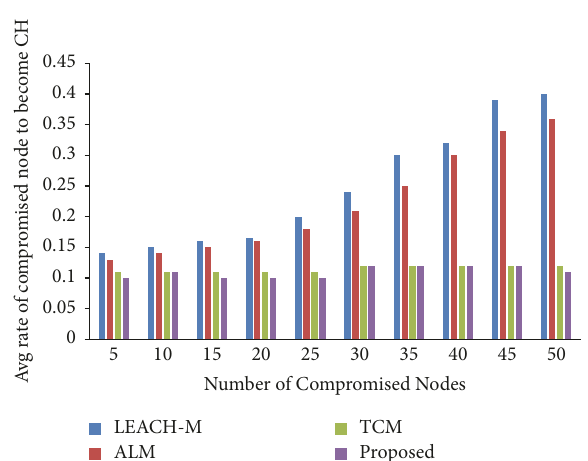
Figure 2: Average rate of compromised node become CH versus number of compromised nodes.